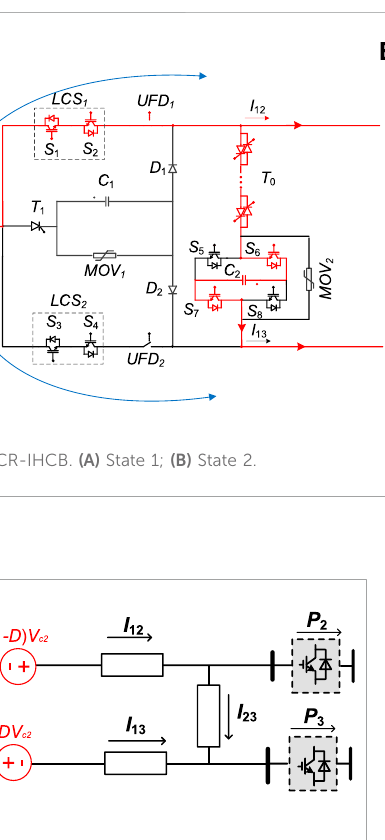
FIGURE 3 Average model of three-terminal DC grid with SCR-IHCB in current control